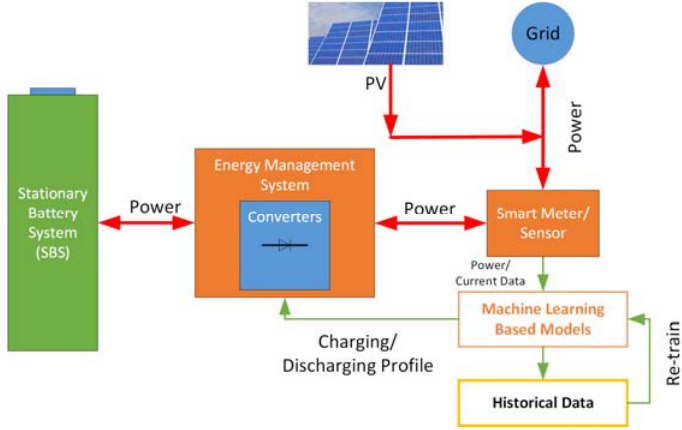
Figure 2. Architecture for implementing machine-learning based models for SBS used in integration of solar PV.